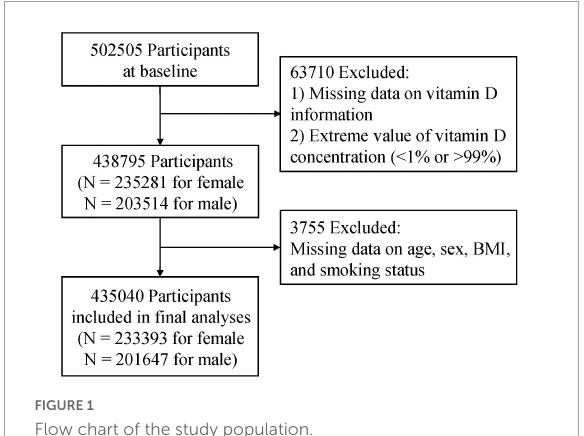
FIGURE1 Flow chart of the study population.